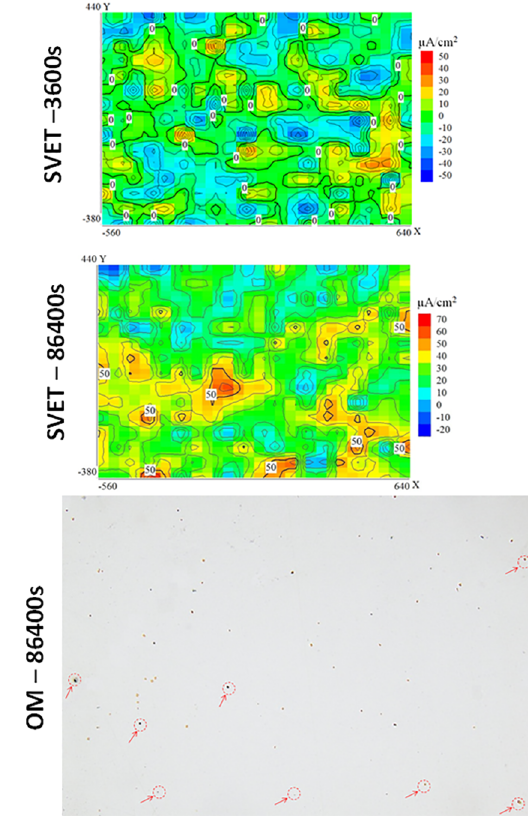
Figure 11. SVET images and optical micrographs (OM) of tempered SMSS surface immersed in 0.1 mol/L NaCl. Pit locations are indicated by red circles and arrows in